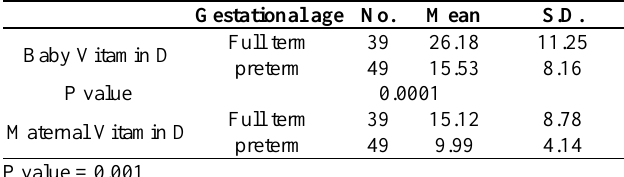
Table 4: Maternal and neonatal Vitamin D mean and standard deviation according to gestational